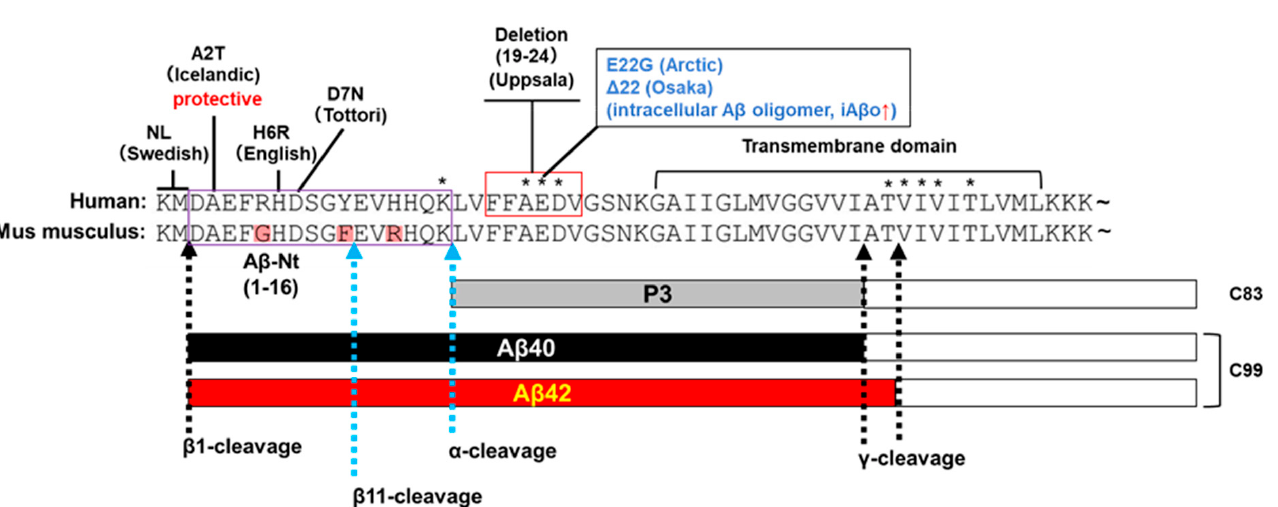
Figure 3. A schematic view of the C99 sequence. Mus musculus sequence comparison is included to discuss differences in A β -Nt (purple square). The names and sites of the FAD gene mutations described in this review are listed and mutations associated with increased intracellular A β oligomers (iA β o) are indicated in blue. Deletion sites for the Uppsala mutation are indicated by red squares. Other mutations within the A β sequence that are not mentioned are marked with an asterisk (*). The difference between A β 40 and A β 42 is due to fluctuations in the γ -secretase cleavage